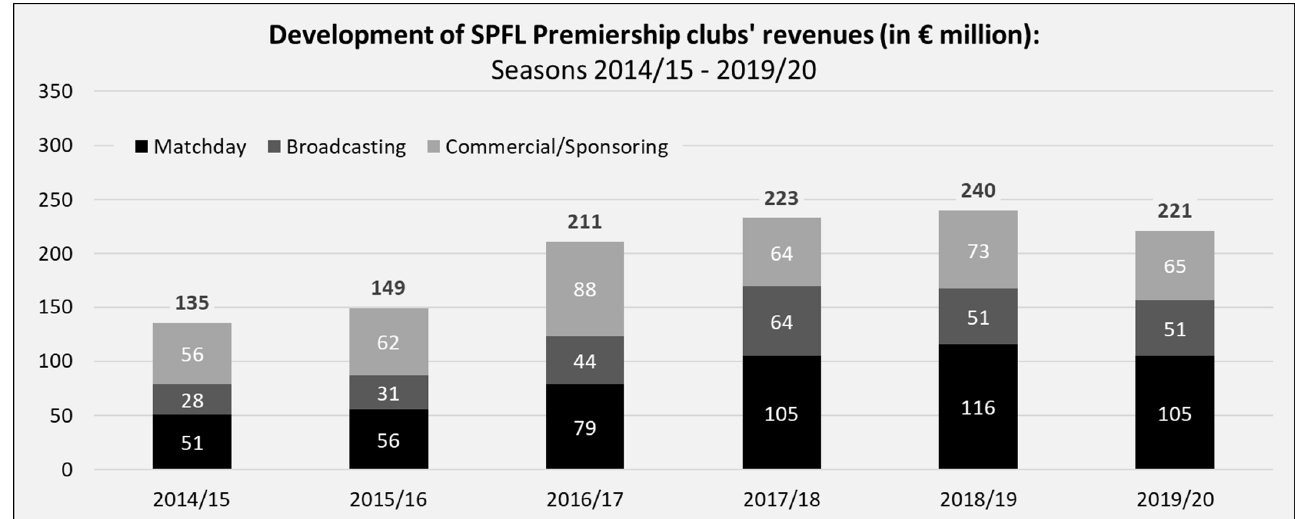
Figure 1. Revenue development in the Scottish Premiership (data from Deloitte 2016, 2017, 2018,